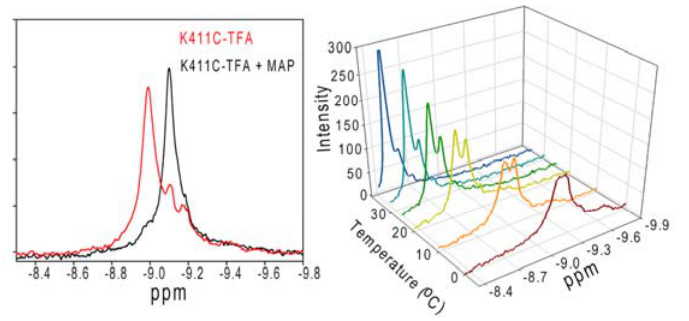
Figure 4. 19 F-NMR analysis of conformational dynamics of inner loop in response to MAP and temperature [60]. ( Left ) Effect of MAP addition on the spectra of K411C-TFA. The red line is a spectrum of K411C-TFA and shows three resonances at − 8.993, − 9.106, and − 9.193 ppm. The resonance at − 9.193 ppm is due to oxidized free label, did not show any ligand-induced changes, and could be removed by extended washing. The black trace is a K411C-TFA (250 µM) after addition of saturating amount (500 µM) of MAP. Spectra were acquired at 30 °C and referenced to the external standard trifluoroacetate. The data represent 2,048 transients processed with 5 Hz line broadening and a spectral window of 34,617 Hz. ( Right ) Effect of temperature on the 19 F-NMR spectra of un-liganded K411C-TFA (250 µM). Sample conditions were the same as